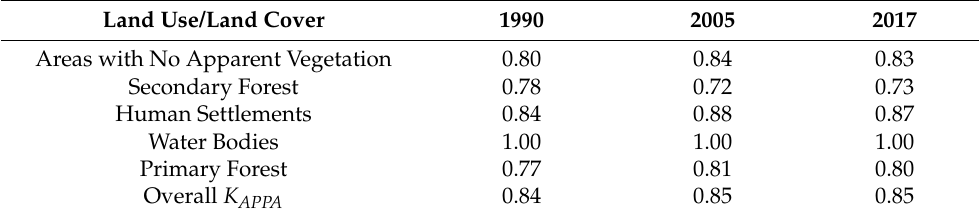
Table 4. Covered area and change rates of land use/land cover for the years 1990, 2005 and 2017. Land Use/Land Cover